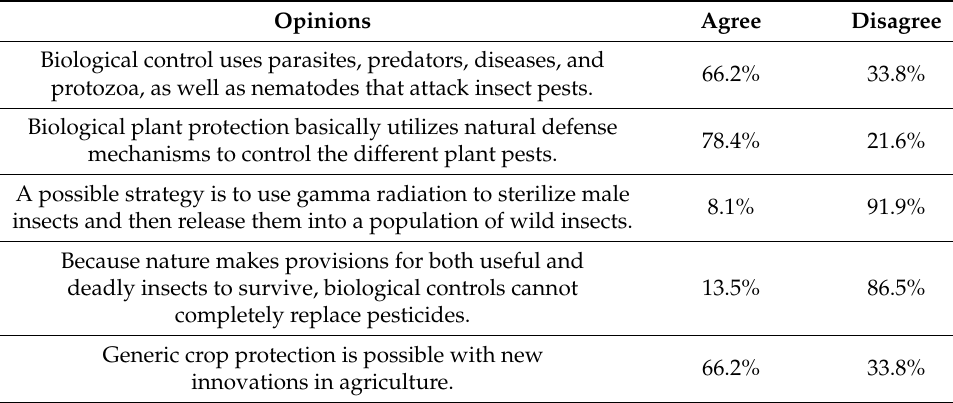
Table 4. Showing opinions on biological techniques with regard to crop protection. Opinions Agree Disagree 66.2%